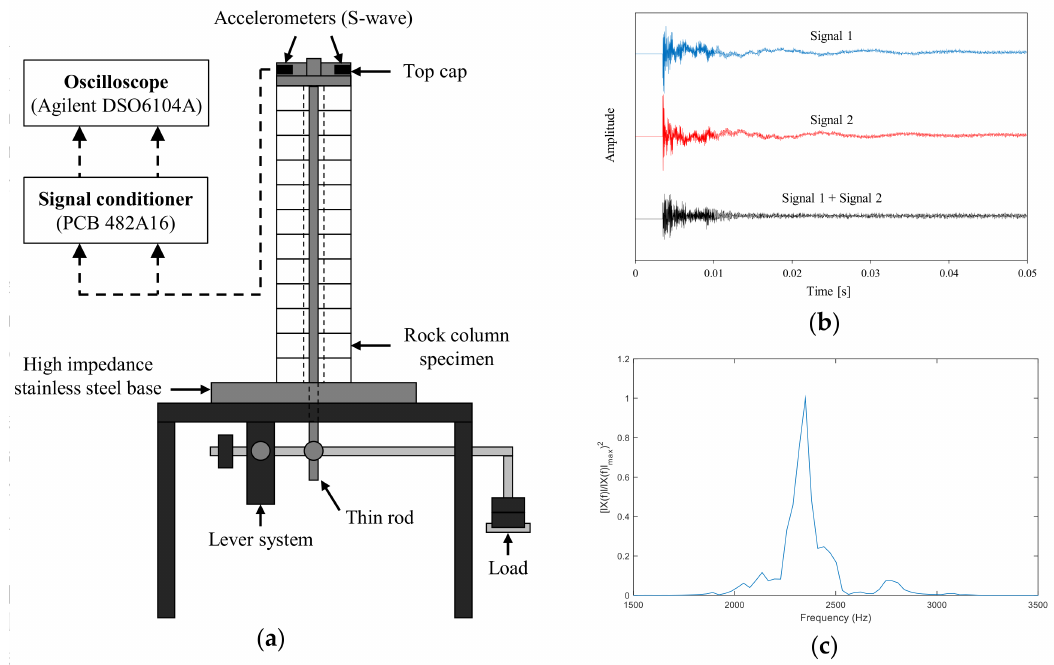
Figure 1. Quasi-static resonant column test (QRCT) apparatus. ( a ) Schematic diagram of the test apparatus; ( b ) Time domain signals obtained from the two accelerometers attached at opposing arms with respect to the axis of rotation. The two signals were added to remove the flexural response; ( c ) Typical frequency domain response